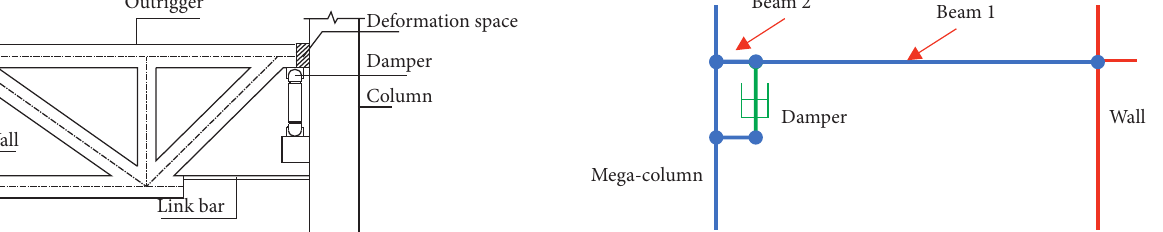
Figure 8: Damper in the simplified